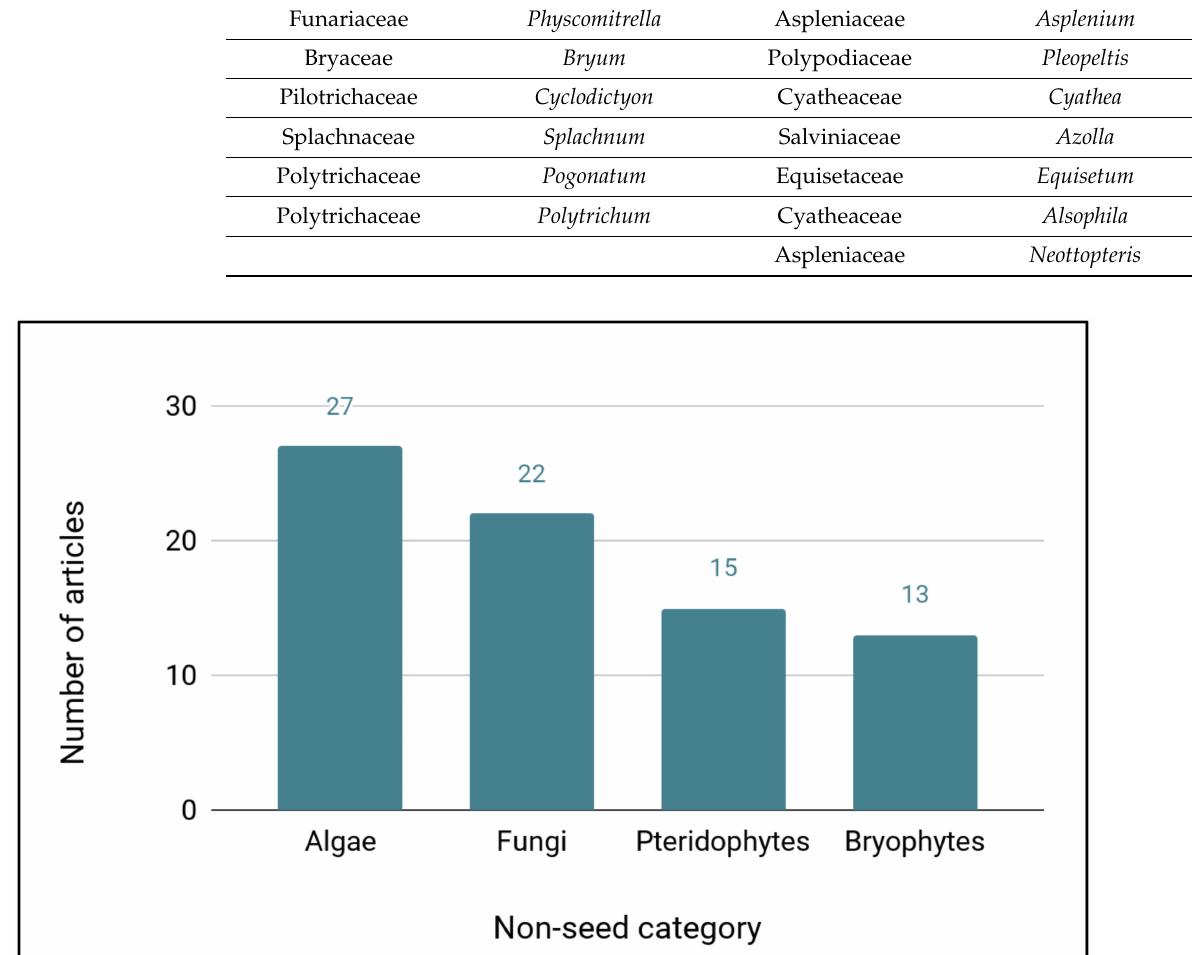
Figure 3. Number of Web of Science articles identified for each category of non-seed plants, algae, and